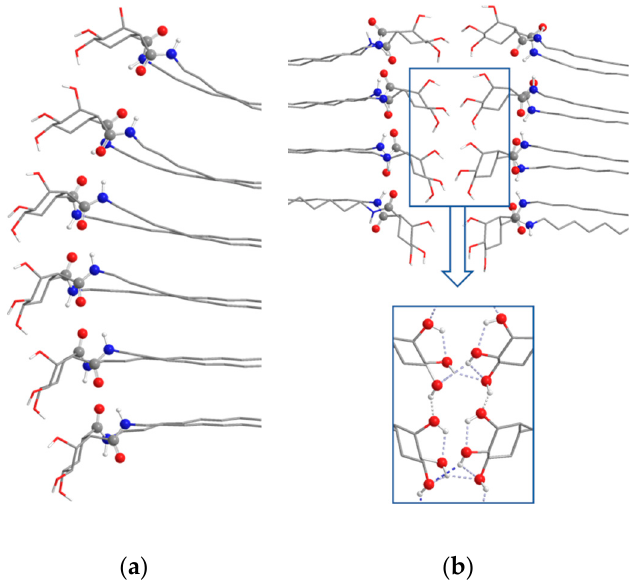
Figure 12. ( a ) Side view of central 6 molecules in octameric 1-D aggregate (amide hydrogen-bonds) 17 - α . ( b ) Side views of octameric 2-D aggregates (amide and hydroxyl hydrogen-bonds) 17 - β . Non-polar hydrogen atoms have been omitted for clarity. Atoms in amide groups have been represented with red (oxygen), blue (nitrogen) and grey (carbon) spheres [38].